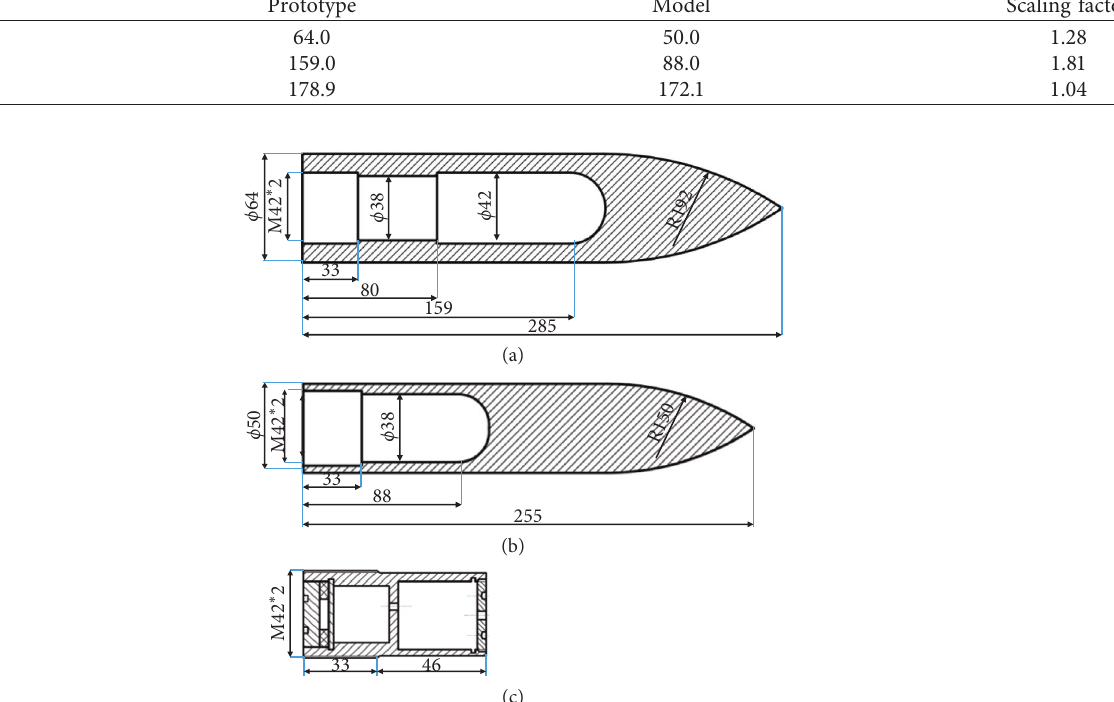
Figure 5: Geometries of projectiles and deceleration measurement device: (a) prototype projectile; (b) nonproportional scaling projectile; (c) deceleration measurement device (dimensions in mm).